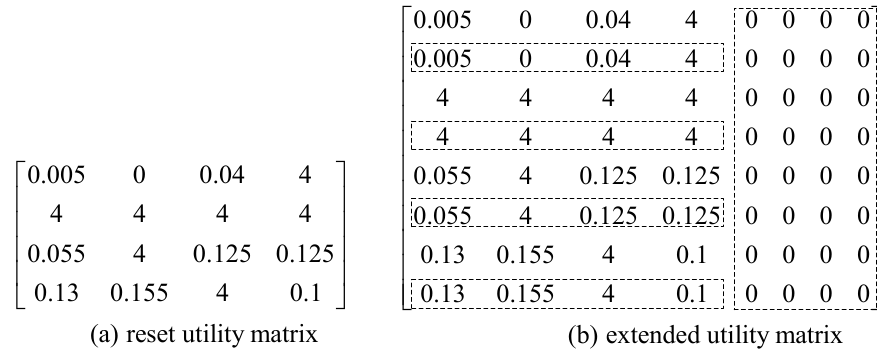
Figure 5. The reset utility matrix and extended utility matrix. Algorithm 2: Utility matrix reset and extension